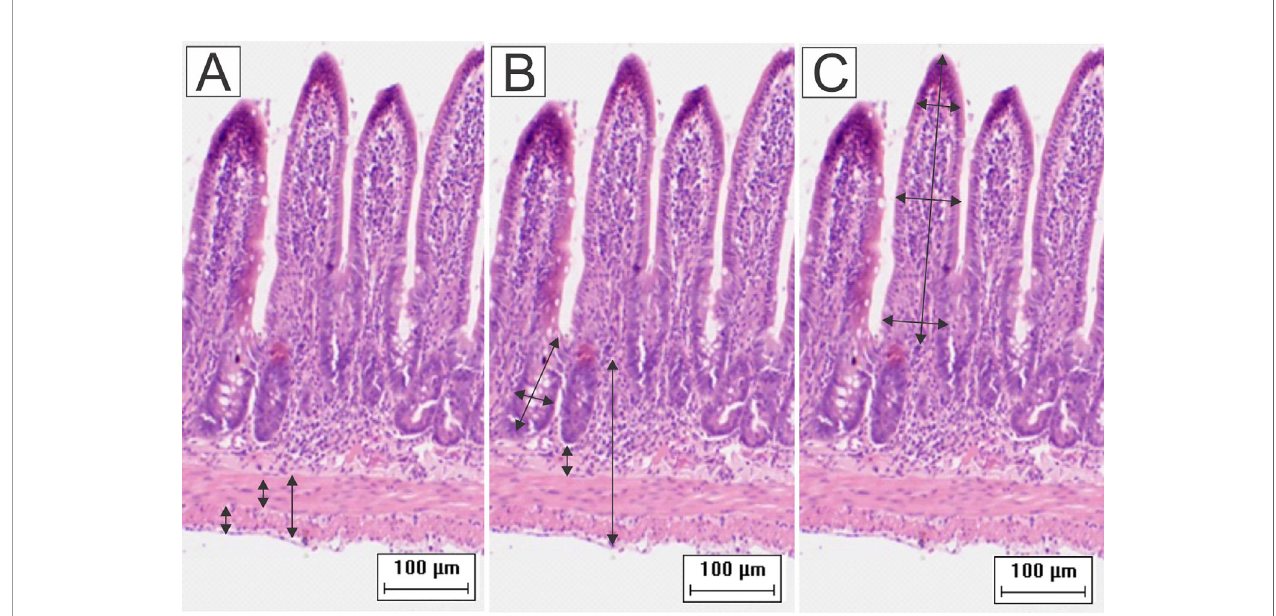
FIGURE 1 | Schematic representation of the measurement of (A) muscular layers, (B) submucosa, total wall, depth and width of the crypts, and (C) height and width of the villi. Were performed 64 measurements of each parameter for each animal. To obtain the width of the villi, the base, middle, and apex were measured and then the average of these values resulted in the fi nal value (HE staining, 20× magni fi cation, scale bar = 100 μm, Olympus